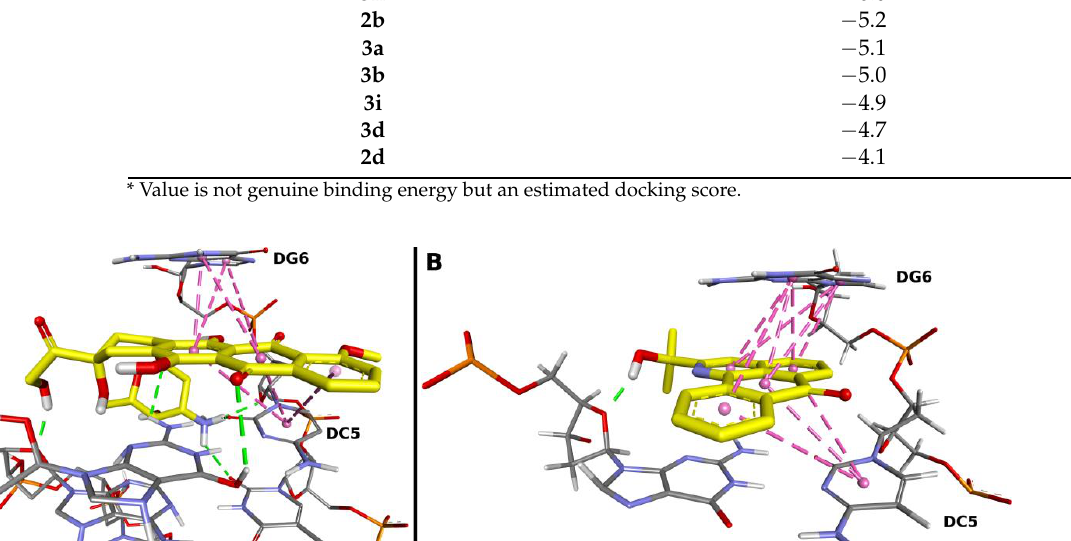
Figure 1. ( A ) ― intercalation of doxorubicin into DNA, ( B ) ― intercalation modeling for 3j . Ligands are yellow, non-cova- Figure 1. ( A )—intercalation of doxorubicin into DNA, ( B )—intercalation modeling for 3j . Ligands are yellow, non-covalent lent interactions are shown by dashed lines: pink ― stacking interactions, green ― hydrogen bonds. interactions are shown by dashed lines: pink—stacking interactions, green—hydrogen